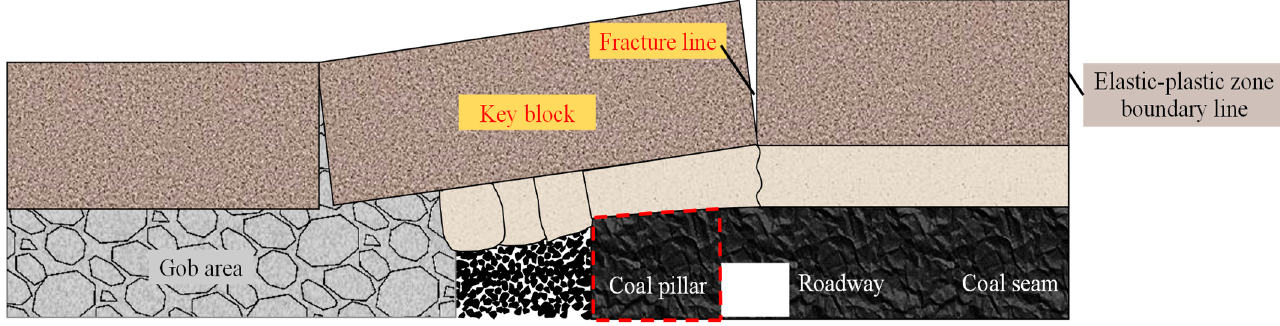
Figure 16. Structure model with main roof fracture line above the roadway [53].